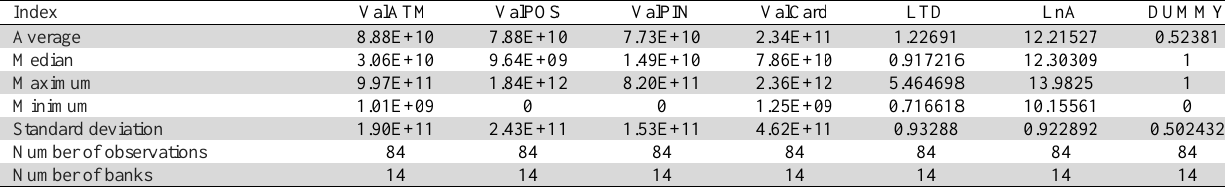
s of the stud of depende . description o ation servations nks description o n vations he conducted ll studied b degree